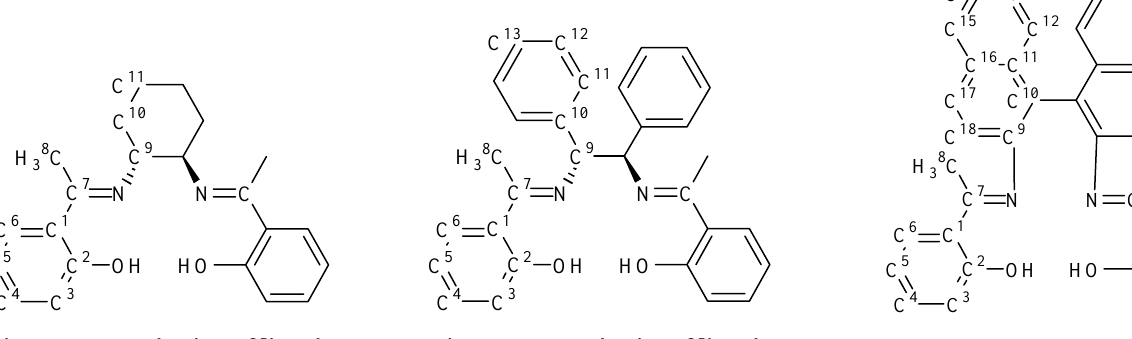
Fig.1 NMR numbering of ligand 2 Fig.2 NMR numbering of ligand 3 Fig.3 NMR numbering of ligand